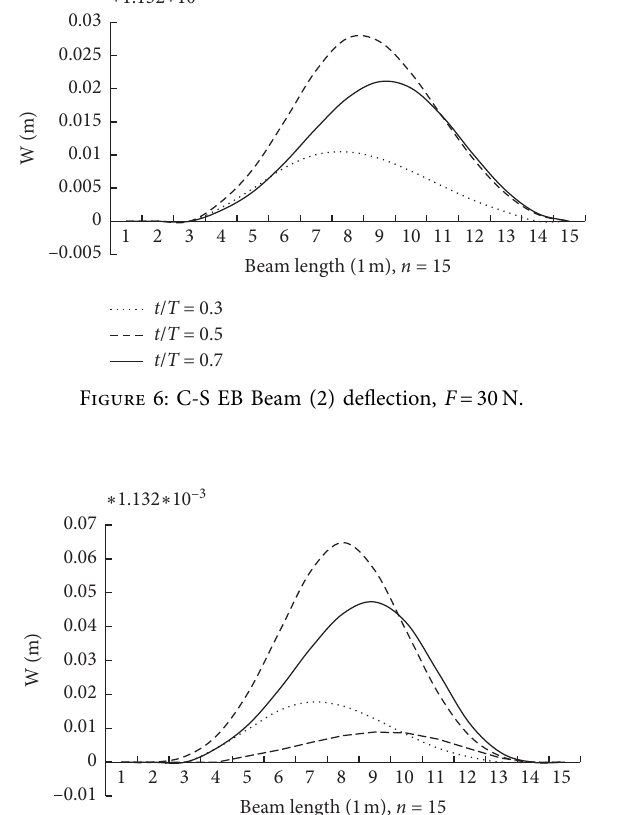
t / T = 0.3 t / T = 0.5 Figure 7: C-C EB Beam (3) deflection, F � 30N.